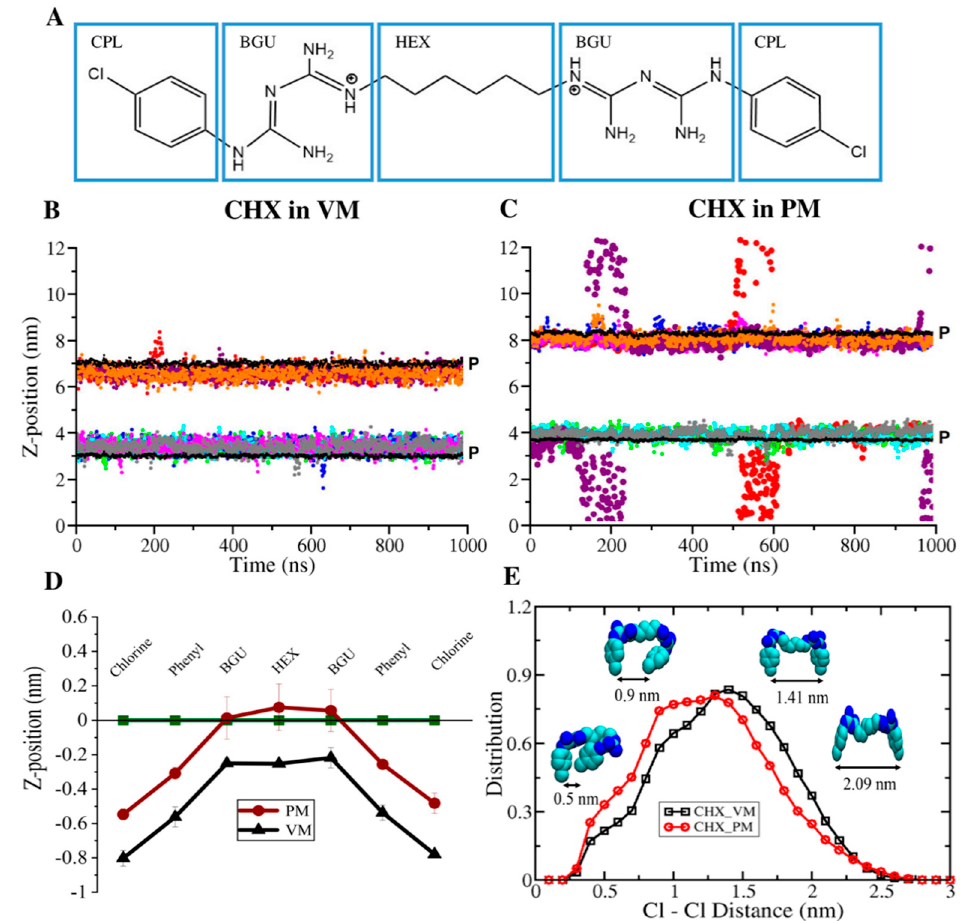
Figure 1. ( A ) Structure of dicationic chlorhexidine (CHX) molecule showing its different functional groups, chlorophenyl (CPL), biguanide (BGU), and hexane (HEX). ( B , C ) The center of mass distribution of individual CHX molecules along the normal bilayer, starting from membrane bound CHX. The black lines represent the average planes of P atoms of two bilayer leaflets. Individual CHX molecules are colored separately. ( D ) Z-positions of the functional groups of membrane-bound CHX with reference to the P plane (indicated by line at Z = 0). ( E ) Distribution of ClCl distance of CHX in membranes. Table 1. The plasma membrane (outer leaflet) composition used in